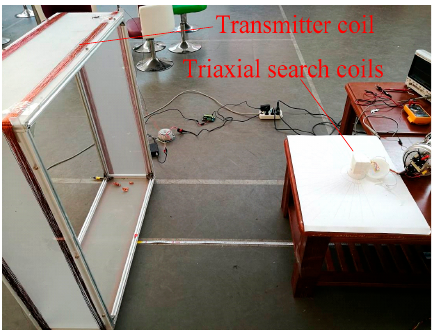
Figure 16. Test on deflection angle measurement.